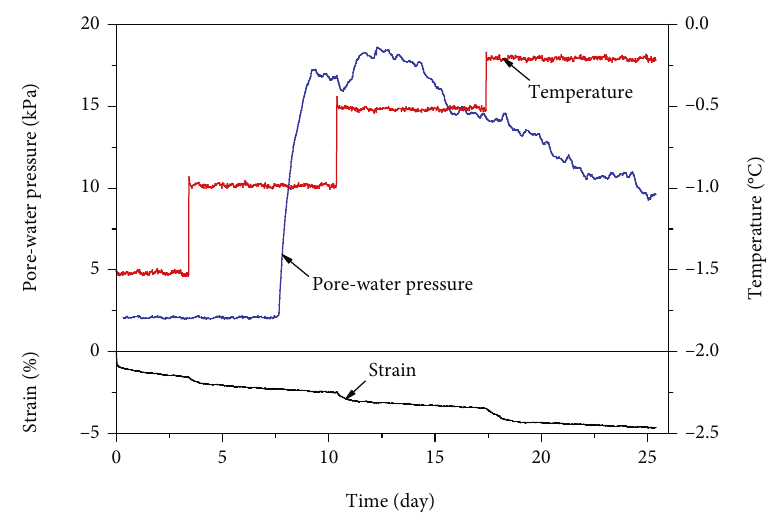
Figure 11: Pore-water pressure variation with warming temperature